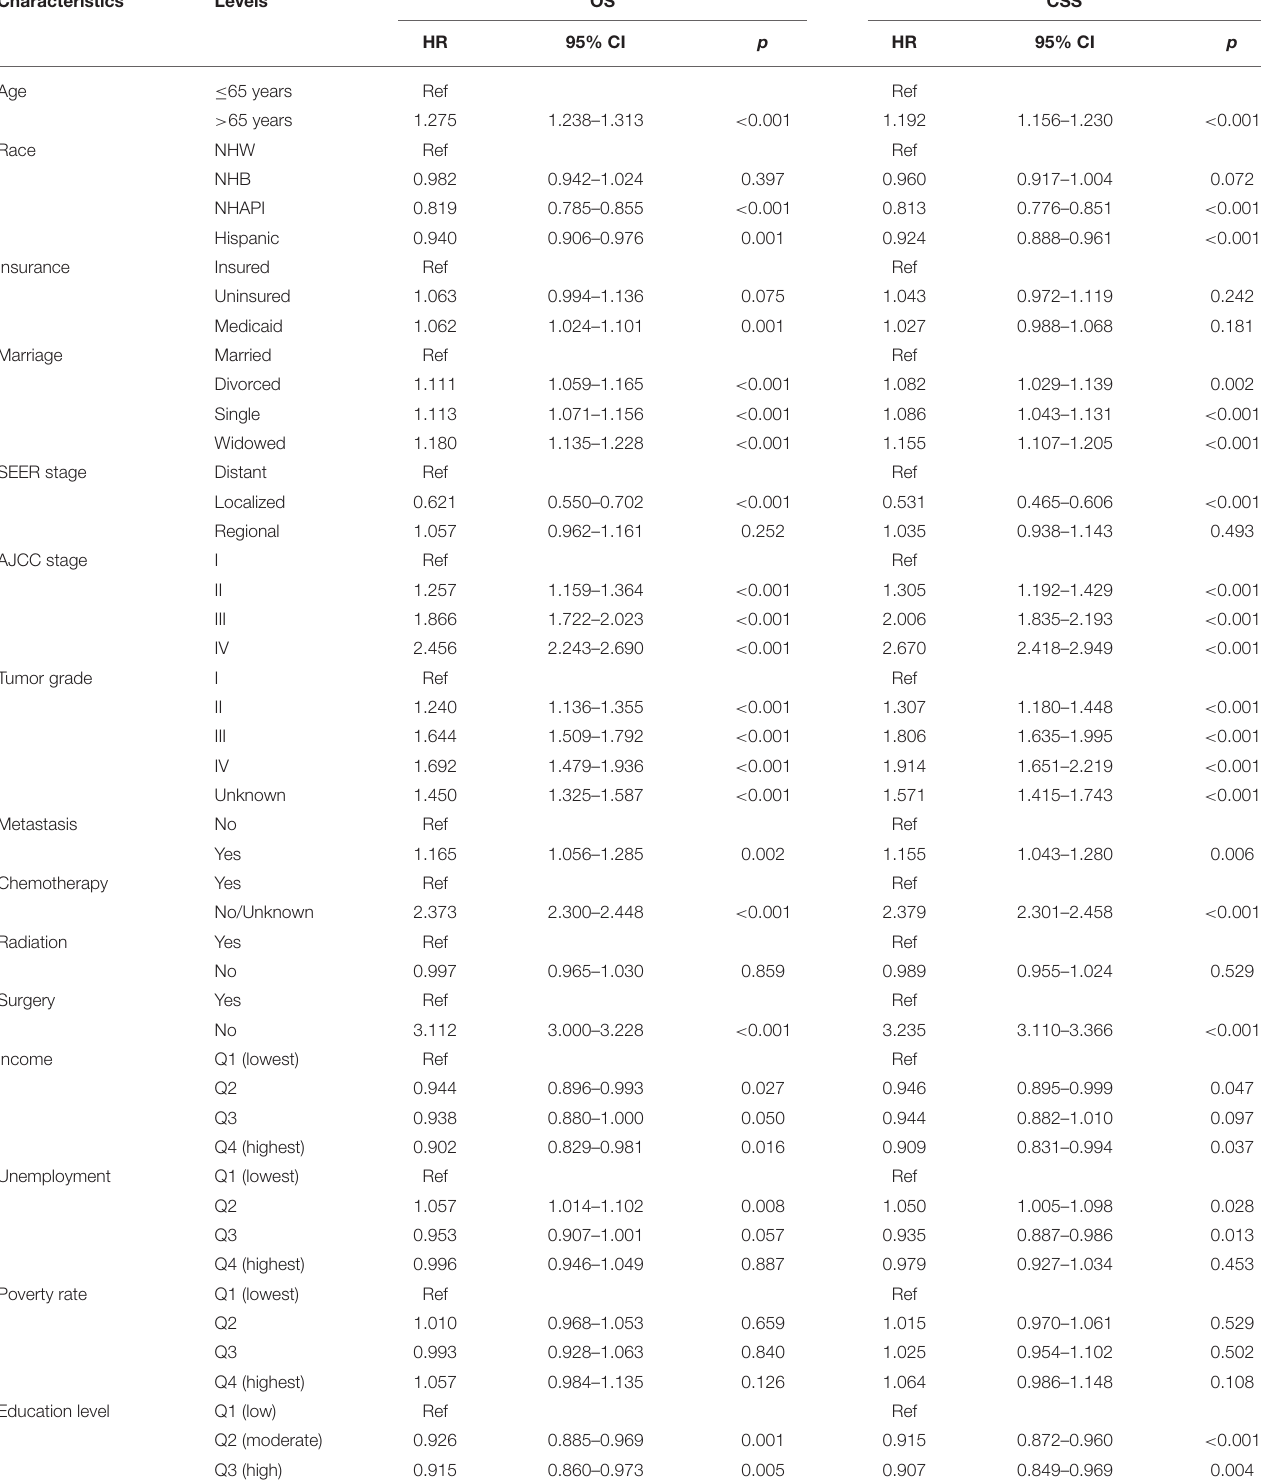
TABLE 3 | Multivariate cox analysis of OS and